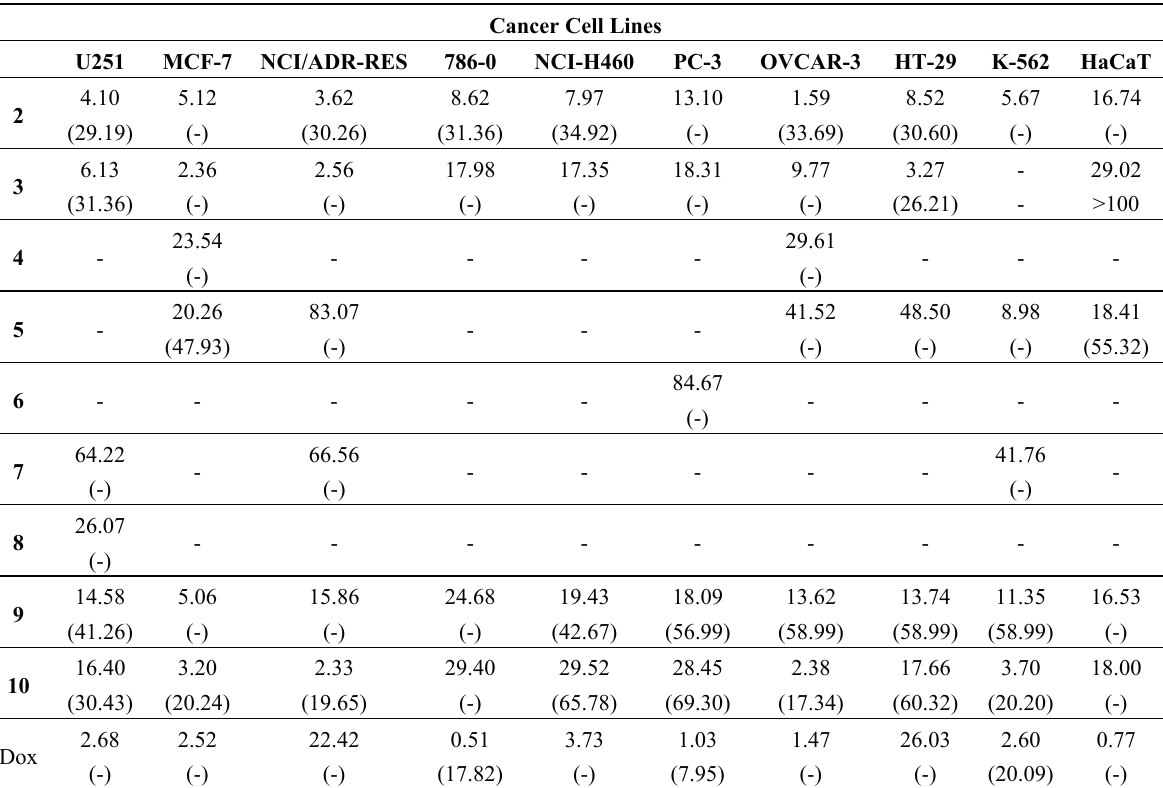
Table 2. TGI and LC 50 (values in parentheses ) in µg/mL for compounds 2 – 10 in ten tumor cell